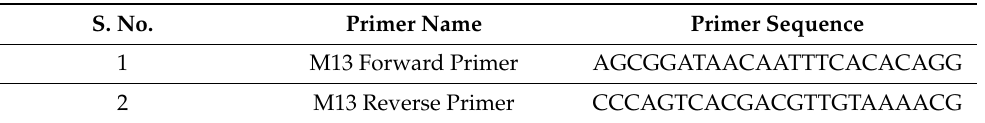
Table 2. Sequences of primers used for colony PCR. Vector-specific universal M13 forward and reverse primer